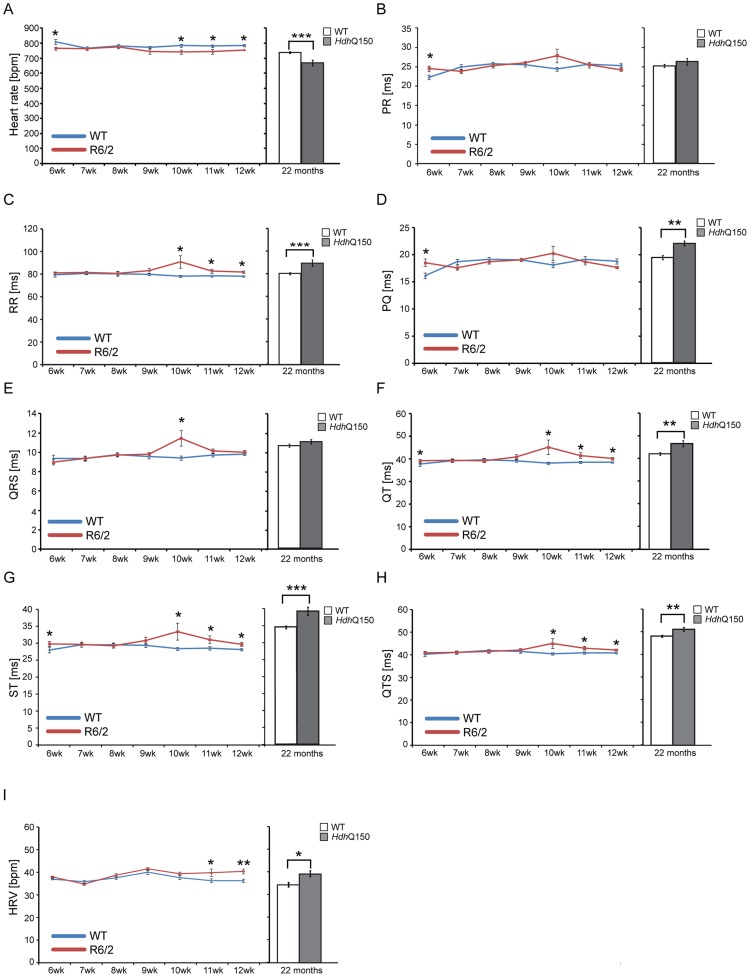
Resting ECG measurements for R6/2 and HdhQ150 mice.ECGs recorded for R6/2 or HdhQ150 mice and their respective WT littermates revealed a significant physiological difference in the symptomatic animals. (A) Heart rate, (B) PR interval, (C) RR interval, (D) PQ interval, (E) QRS interval (F) QT interval, (G) ST interval (H) QTS interval and (I) HRV. All values are expressed as mean±SEM (n≥6 mice per data point). All mice were conscious and unrestrained. One-way ANOVA with Bonferroni post-hoc test: *p<0.05, **p<0.01, ***p<0.001.